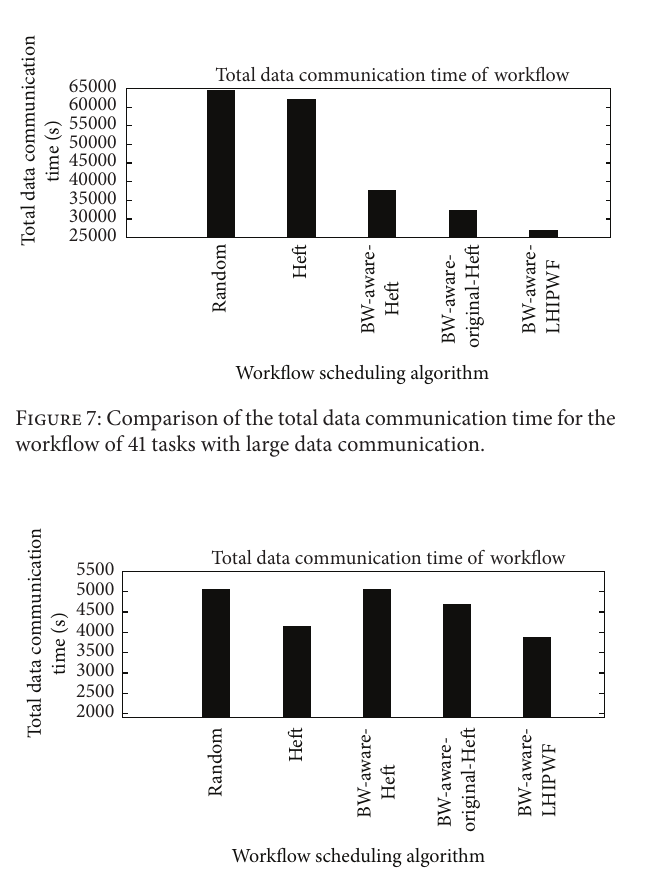
Figure 8: Comparison of the total data communication time for the workflow of 41 tasks with small data communication.